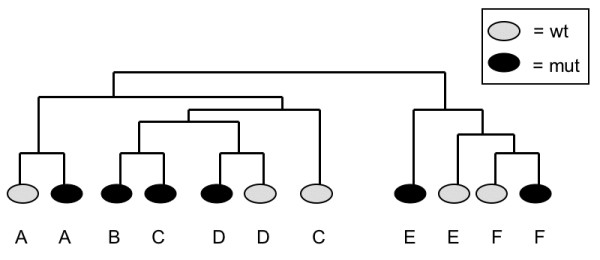
Hierarchical clustering of microarray data from six mutant/wildtype sib pairs. Male B-allele mutants at 8 wk of age, when most of them are symptomatic, tended to cluster with their wt sibs rather than with mutants of other litters. Litters are identified by A – F. The array of the litter B wild-type sib did not pass quality control standards.